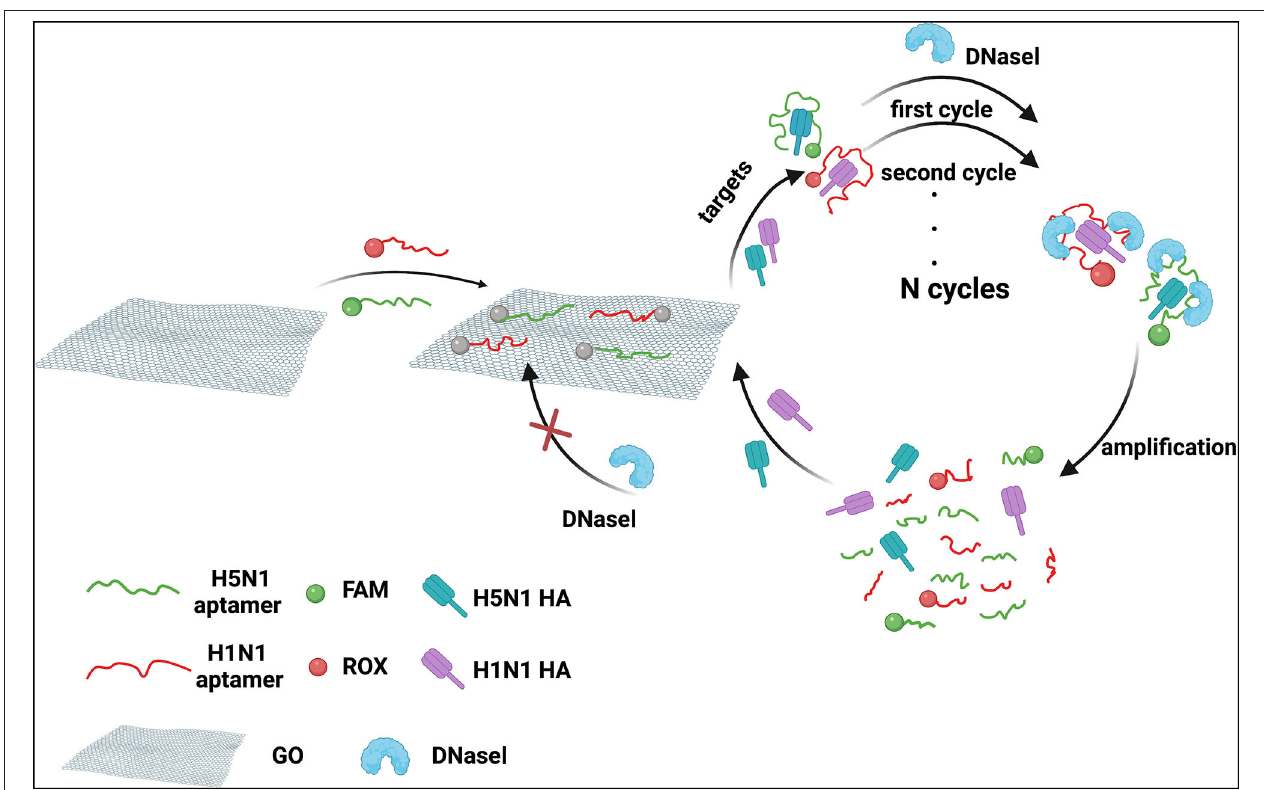
FIGURE 1 | Schematic diagram of dual detection of HA protein from influenza viruses H5N1 and H1N1 based on FRET combined with DNase I.